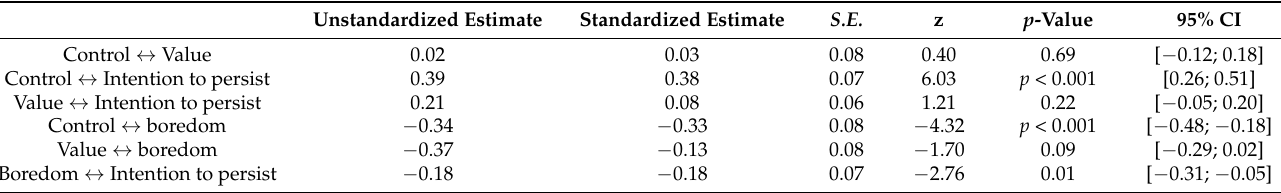
Table 3. Regression coefficients between factors.